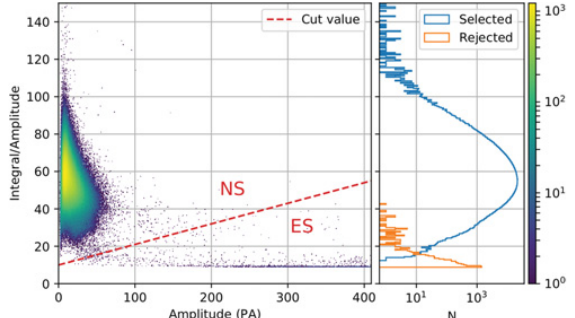
Figure 10. CANDLE plots for 50 planes showing light yield and relative neutron efficiency. Red candles are measured with 22 Na, blue candles with 252 Cf and green with AmBe. Filled boxes represent the plane’s cubes between the first and third quartiles. Black lines represent cubes below and above